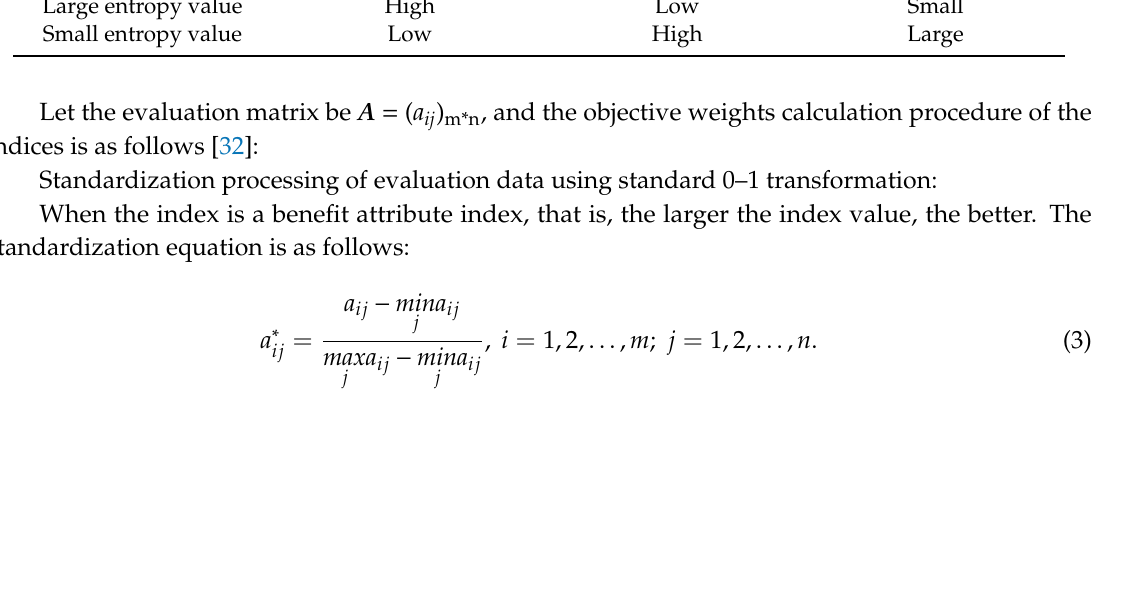
Table 2. Relationship between entropy weight and entropy value. Disorder of